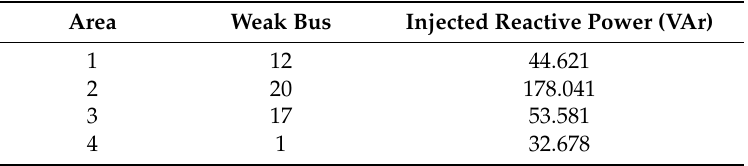
Table 6. Equilibrium generator settings for all areas with renewable